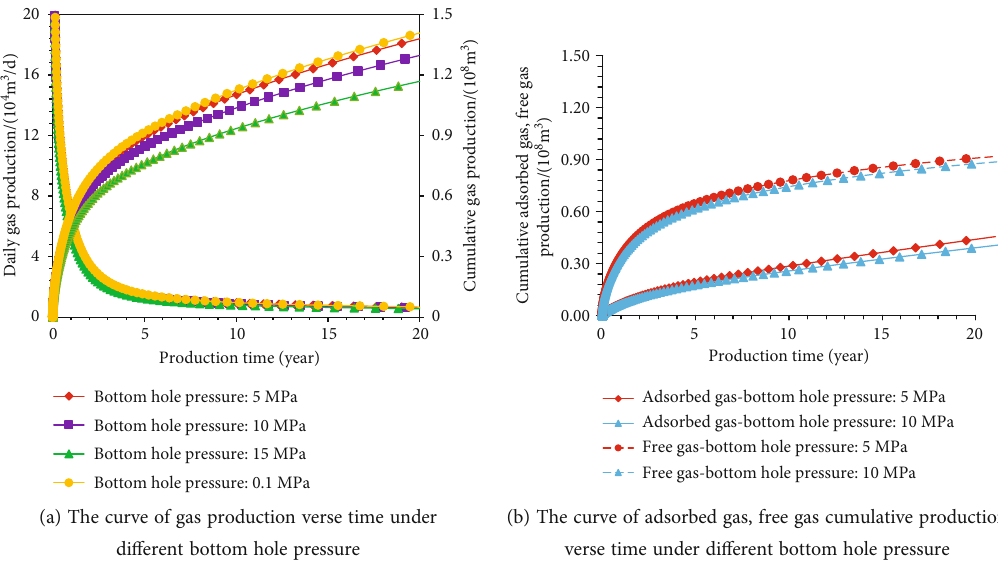
Figure 12: E ff ect of bottom hole pressure on shale gas